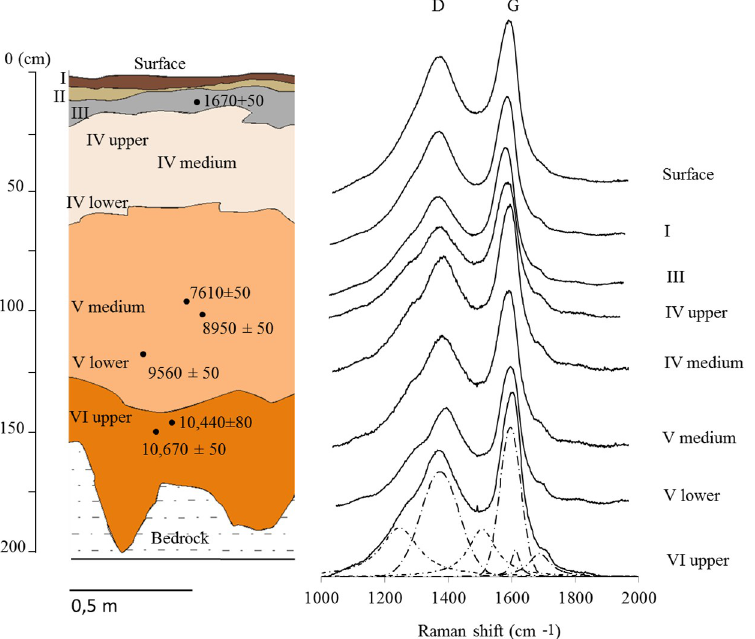
Fig 5. Schematic profile of the stratigraphy of the archaeological site Bibocas II by De´borah Duarte and Luis Felipe Bassi (A). Raman spectra of charcoal superimposed according to stratigraphy (B).